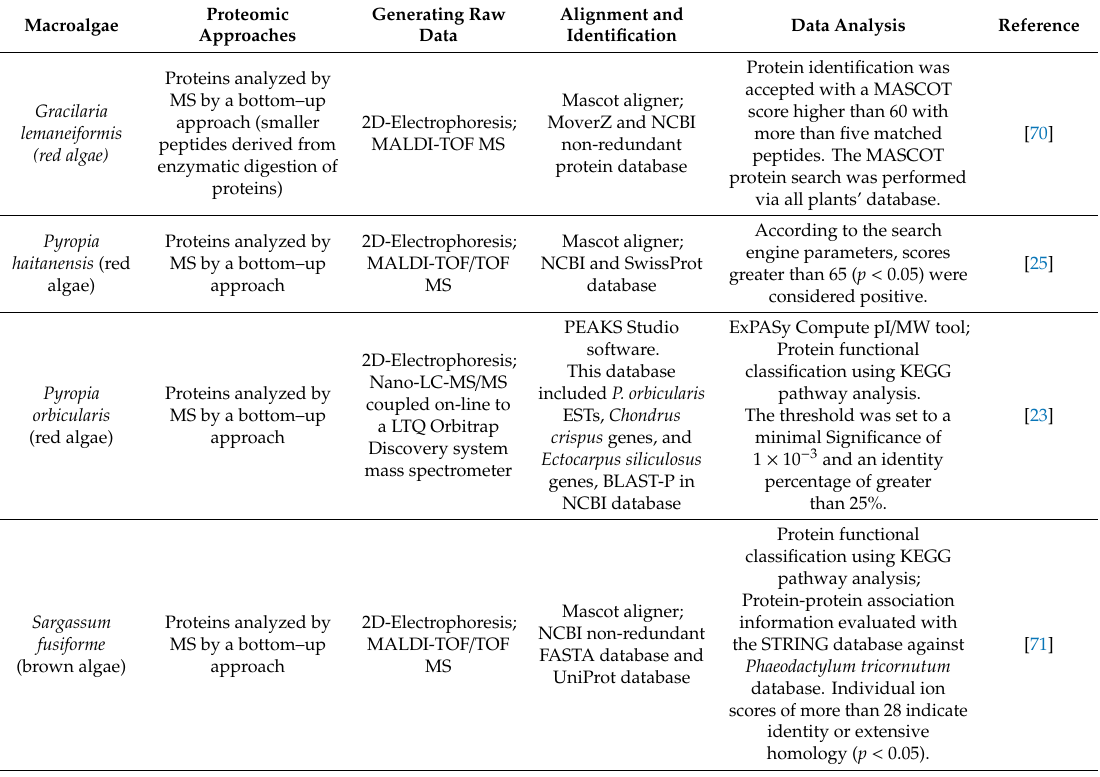
Table 2. Typical Proteomic approaches according to the investigation of how protein regulation in macroalgae can be influenced by abiotic